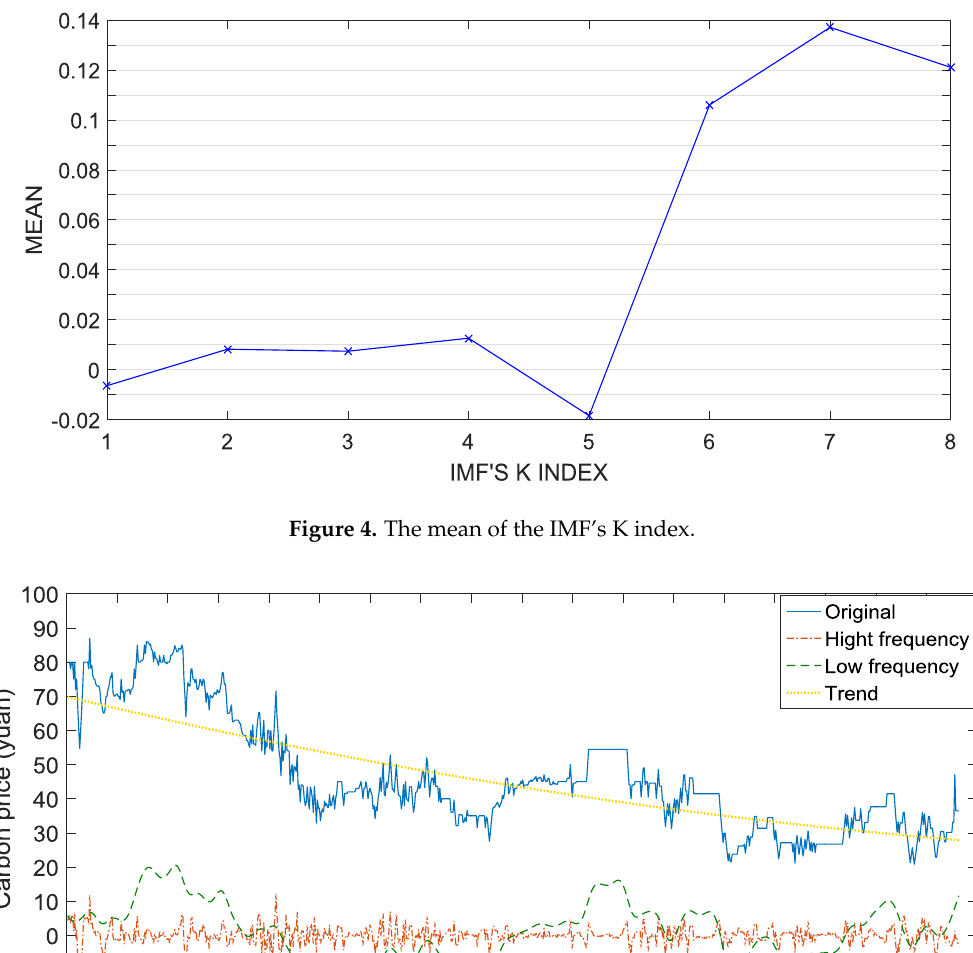
Figure 5. The three components of the original price sequence. Table 5. Correlations and variances of the components.